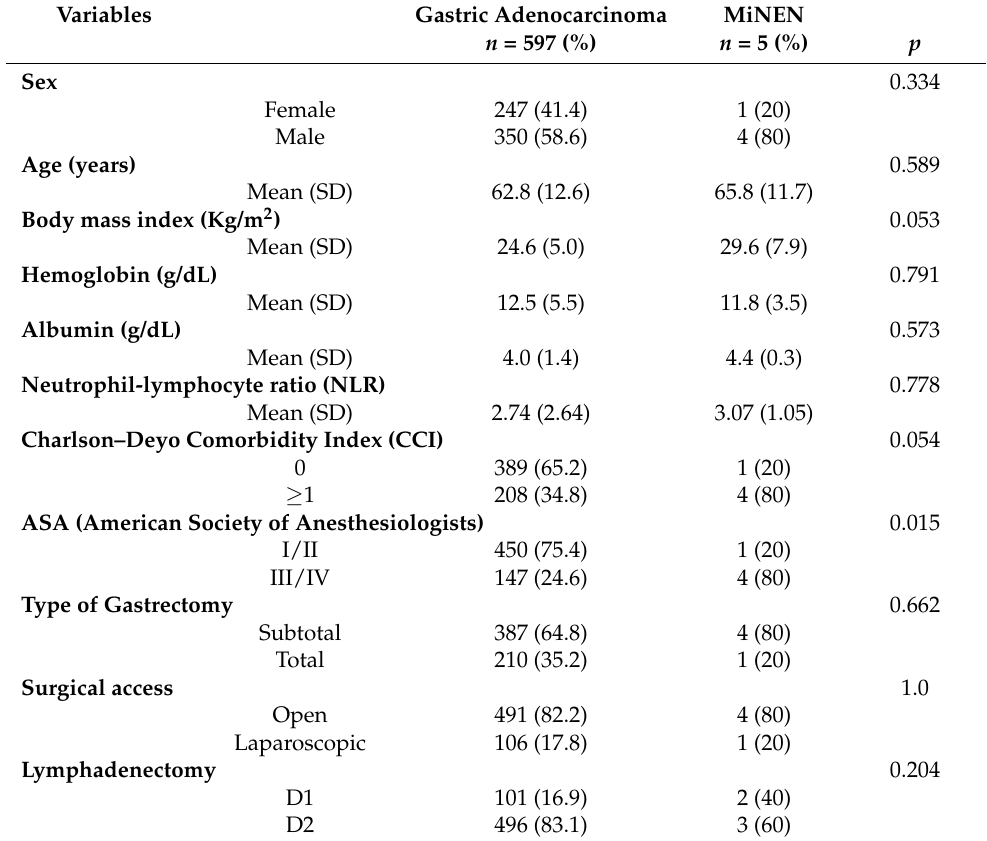
Table 1. Clinical and surgical characteristics of patients with gastric adenocarcinoma and MiNEN. Variables